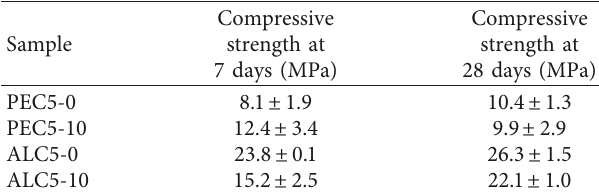
Table 3: Compressive strength of LWC manufactured with perlite (PEC) and with aliven (ALC) to 7 and 28 days with and without addition of